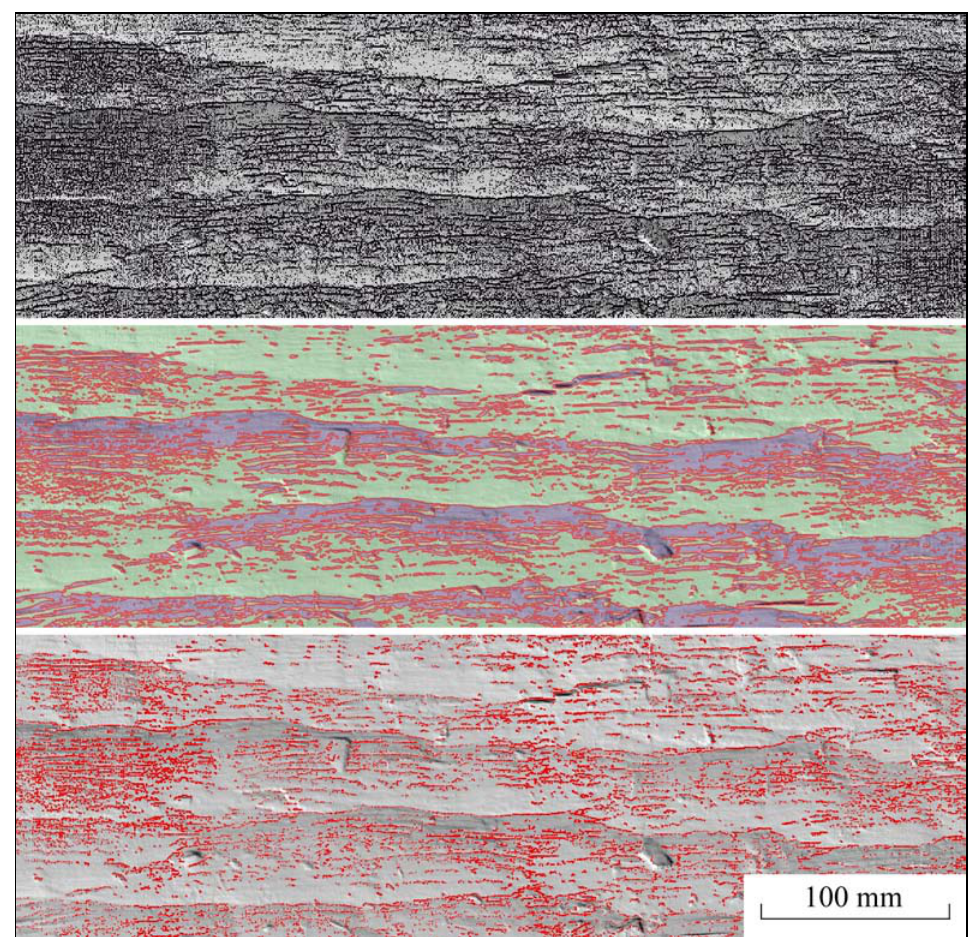
Figure 3abc. a (top) - The local maxima of the surface model indicated by black points; b (middle) - The aspect calculations and the buffer zones indicated by red shapes; c (bottom) – The selected raster cells indicated by red points after the overlap